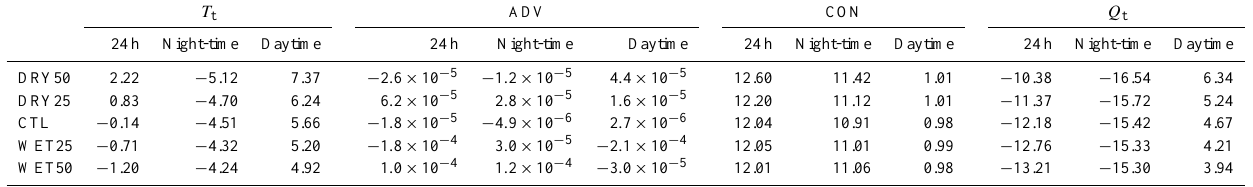
Table 2. Area-averaged 10-day mean integral results of the four terms in the T z 1 equation (i.e. Eq. 2) for 24h, night-time (11:00–22:00UTC) and daytime (22:00–06:00UTC) (unit: ◦ C). Note that the daytime is divided into two periods (by the night hours) in the 24h integrations, and only one part, which is assumed to be reasonable and have little influence on the analysis, is considered in the statistics. T t ADV CON Q t 24h Night-time Daytime 24h Night-time Daytime 24h Night-time Daytime 24h Night-time Daytime DRY50